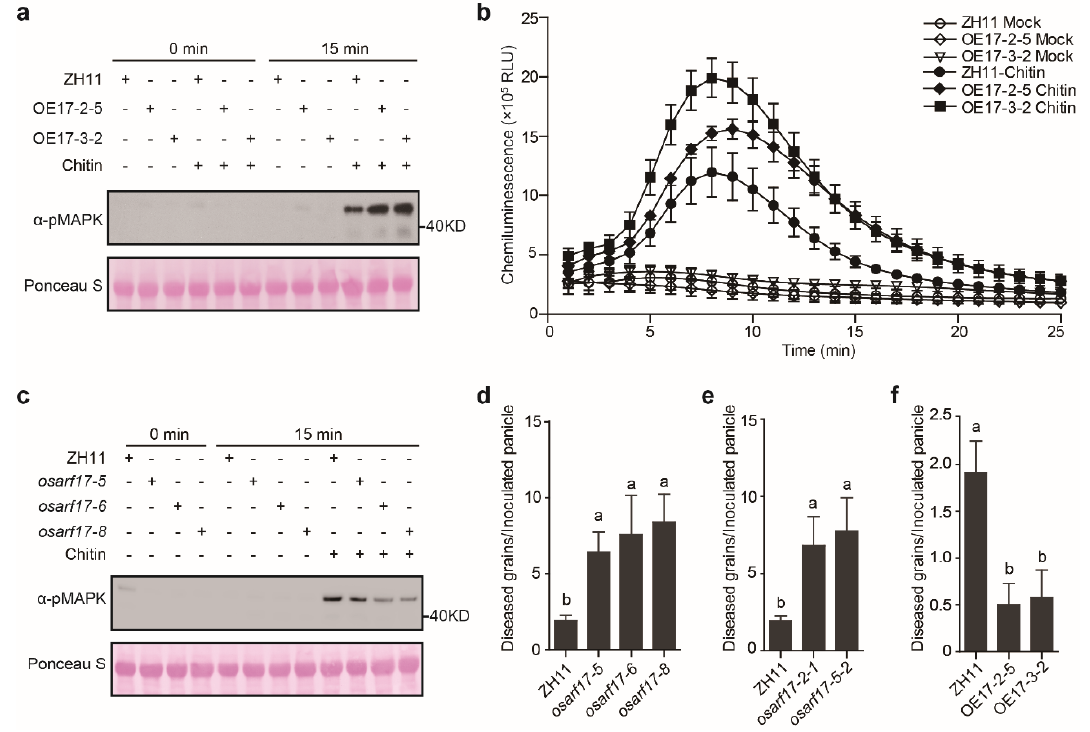
Figure 5. OsARF17 positively regulates rice defense against U. virens . ( a ) The chitin − induced MAPK phosphorylation levels in the wild − type and OsARF17 − overexpressing lines. MAPK phosphoryla- tion was detected by immunoblot analyses with anti − phospho −44/42 MAPK antibody (α− pMAPK). Protein loading is indicated by Ponceau S staining. ( b ) Chitin − triggered ROS burst in the wild − type and OsARF17 − overexpressing lines. The leaves of the wild − type and transgenic lines OE17 − 2 − 5 and OE17 − 3 − 2 were treated with chitin (10 µg mL −1 ) or mock control. ROS burst was detected immedi- ately after treatment within 25 min. ( c ) Chitin − induced MAPK activation detected in the wild − type and osarf17 mutant lines. Chitin treatment and detection of MAPK phosphorylation were performed as described in ( a ). ( d – f ) The average number of diseased grains on inoculated panicles of the wild − type (ZH11) and different transgenic lines. The virulent U. virens isolate PJ52 was injection- inoculated into the wild − type and knockout lines osarf17 − 5 , osarf17 − 6 and osarf17 − 8 ( n = 12, 14, 10, 10) ( d ), the wild − type and mutant lines osarf17 − 2 − 1 and osarf17 − 5 − 2 generated with another sgRNA site ( n = 12, 5, 8) ( e ), and the wild − type, OsARF17 − overexpressing OE17 − 2 − 5 and OE17 − 3 − 2 lines ( n = 12, 12, 12) ( f ). False smut balls were counted on the inoculated panicles 4 weeks after inoculation. The representative data from three independent experiments are shown as mean ± SE. Different letters (a vs. b) indicate a significant difference in the average number of diseased grains between the wild − type and different transgenic lines ( p < 0.05, Duncan’s m ultiple range test).